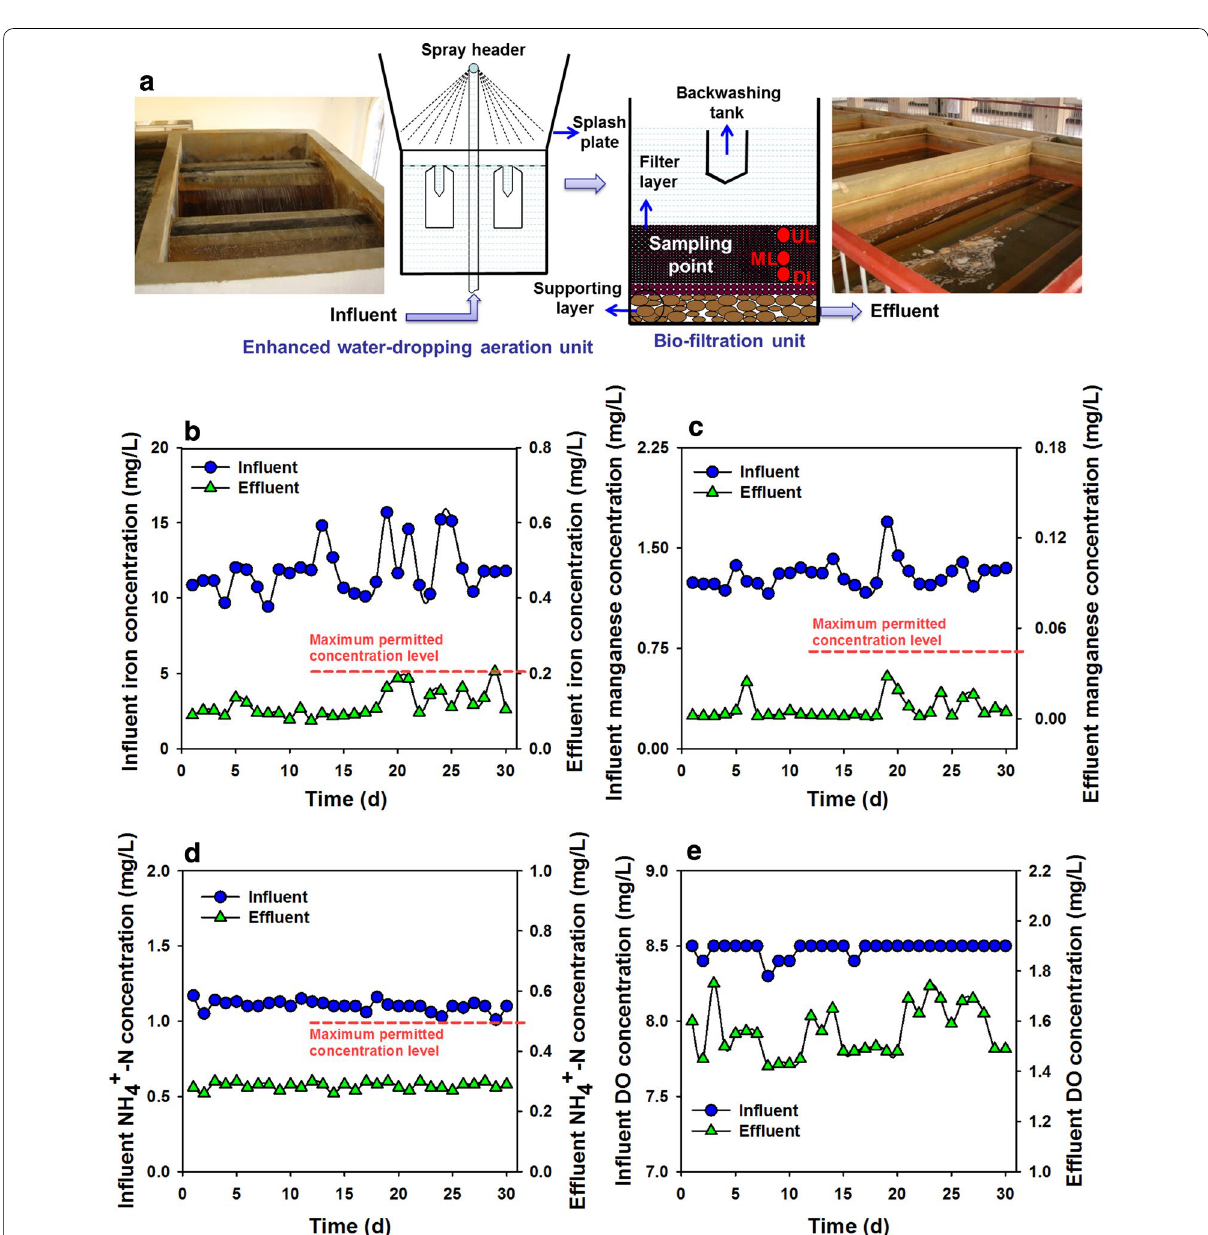
Fig. 1 Schematic and photograph of the enhanced water-dropping aeration and biofiltration process ( a ). Iron ( b ), manganese ( c ) and ammonia ( d ) removal effects and the DO variation ( e ) in the enhanced